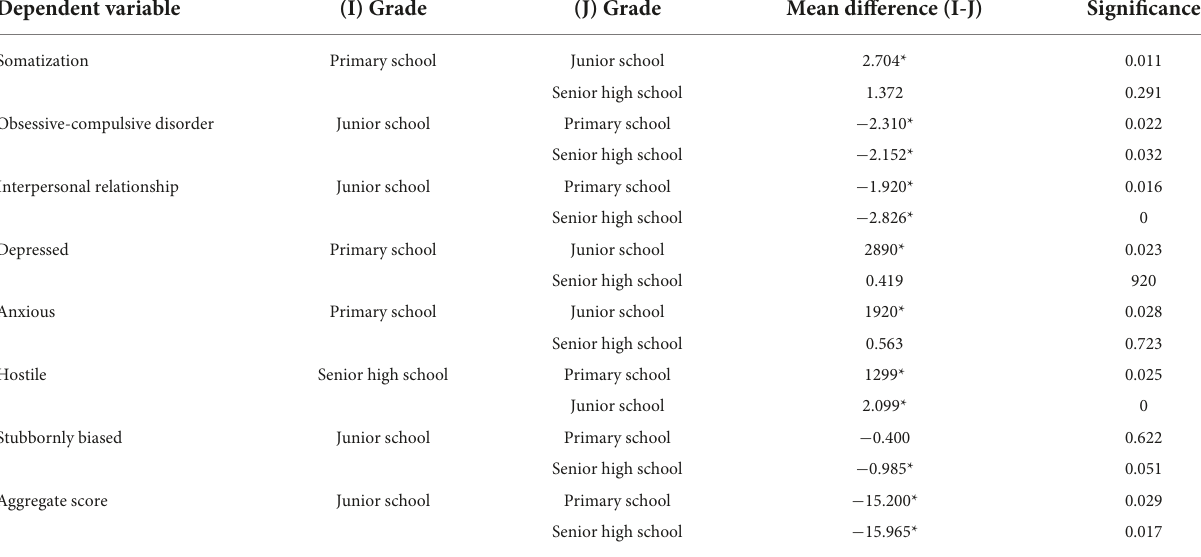
Statistical results of post hoc tests in Table 5 :